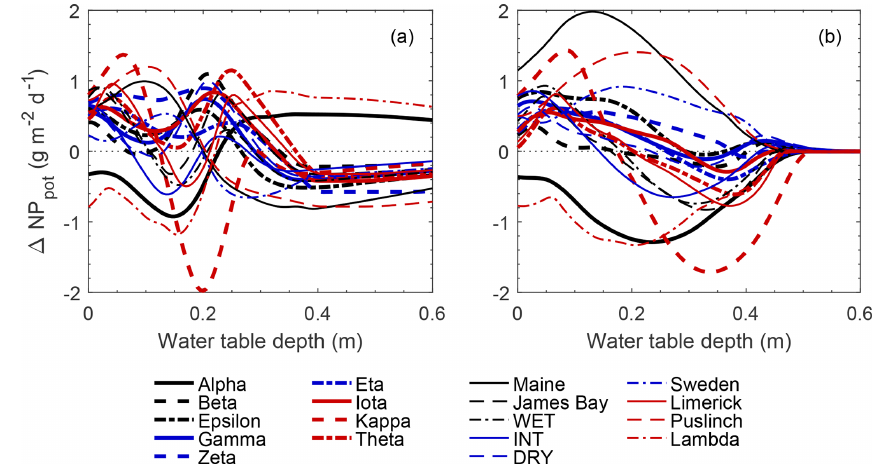
Figure 9. Difference in plot-scale potential net photosynthesis (NP pot ) between models using the measured distribution of elevation over the entire SfM-derived DEM and the measured distribution within hummock–hollow subplots. NP pot is modeled using separate parameterization (see Fig. S5) for each microtopography class (a) , as well as a uniform (low-hummock) parameterization across microtopography classes (b) .